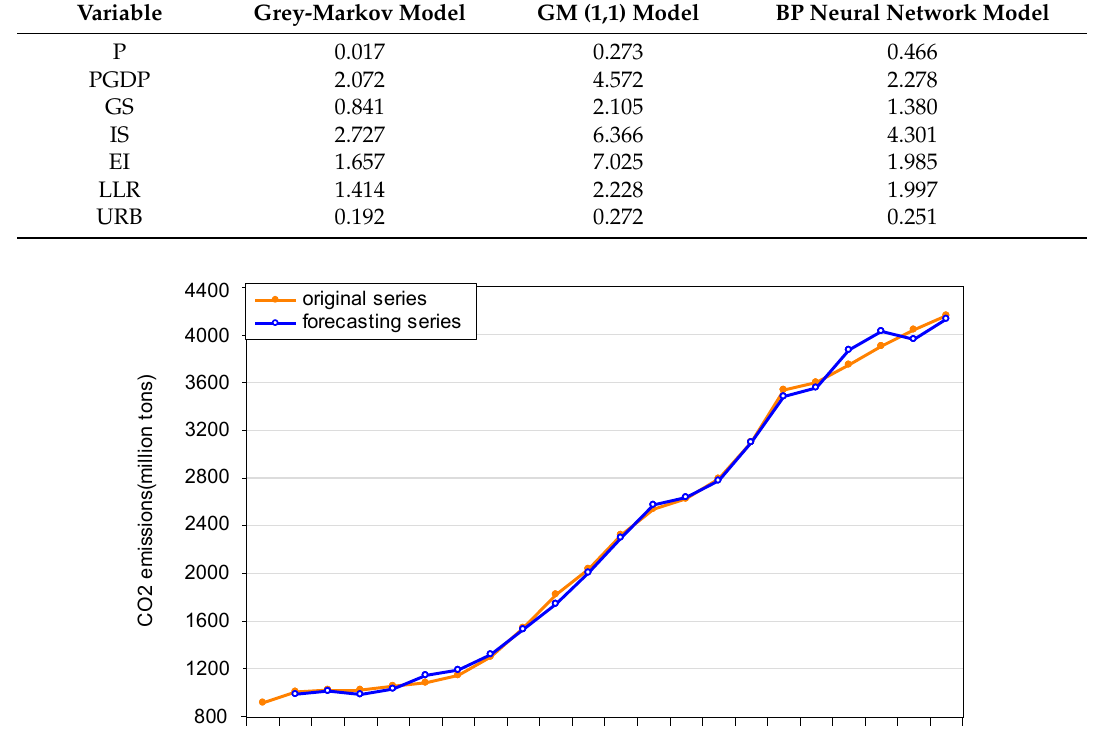
performance comparison of prediction models measured by MAE, MAPE and RMSE is shown in Table 8. It reveals that MAE, MAPE and RMSE of the PLS-Grey-Markov model are less than for other models, indicating the superiority of the novel hybrid model. We can conclude that the